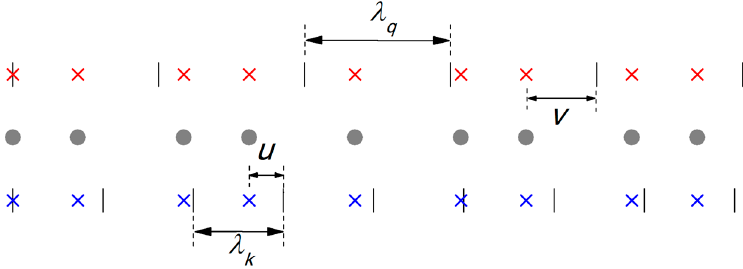
Figure 1. A construction of the average unit cell for two reference lattices (black vertical bars) with lattice constants λ k and λ q . Grey atoms of an arbitrary crystal structure (here the nodes of 1D Fibonacci chain) are projected on reference lattices (red and blue crosses). Distances to the nearest nodes are marked with u and v .